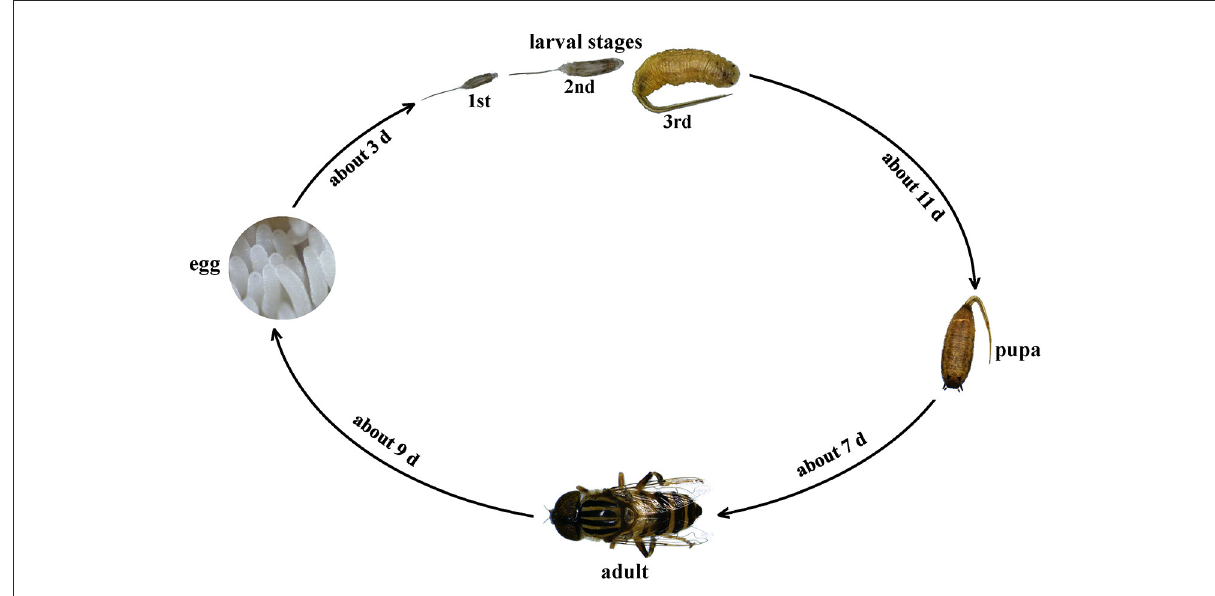
FIGURE1 Life history of Eristalinus arvorum